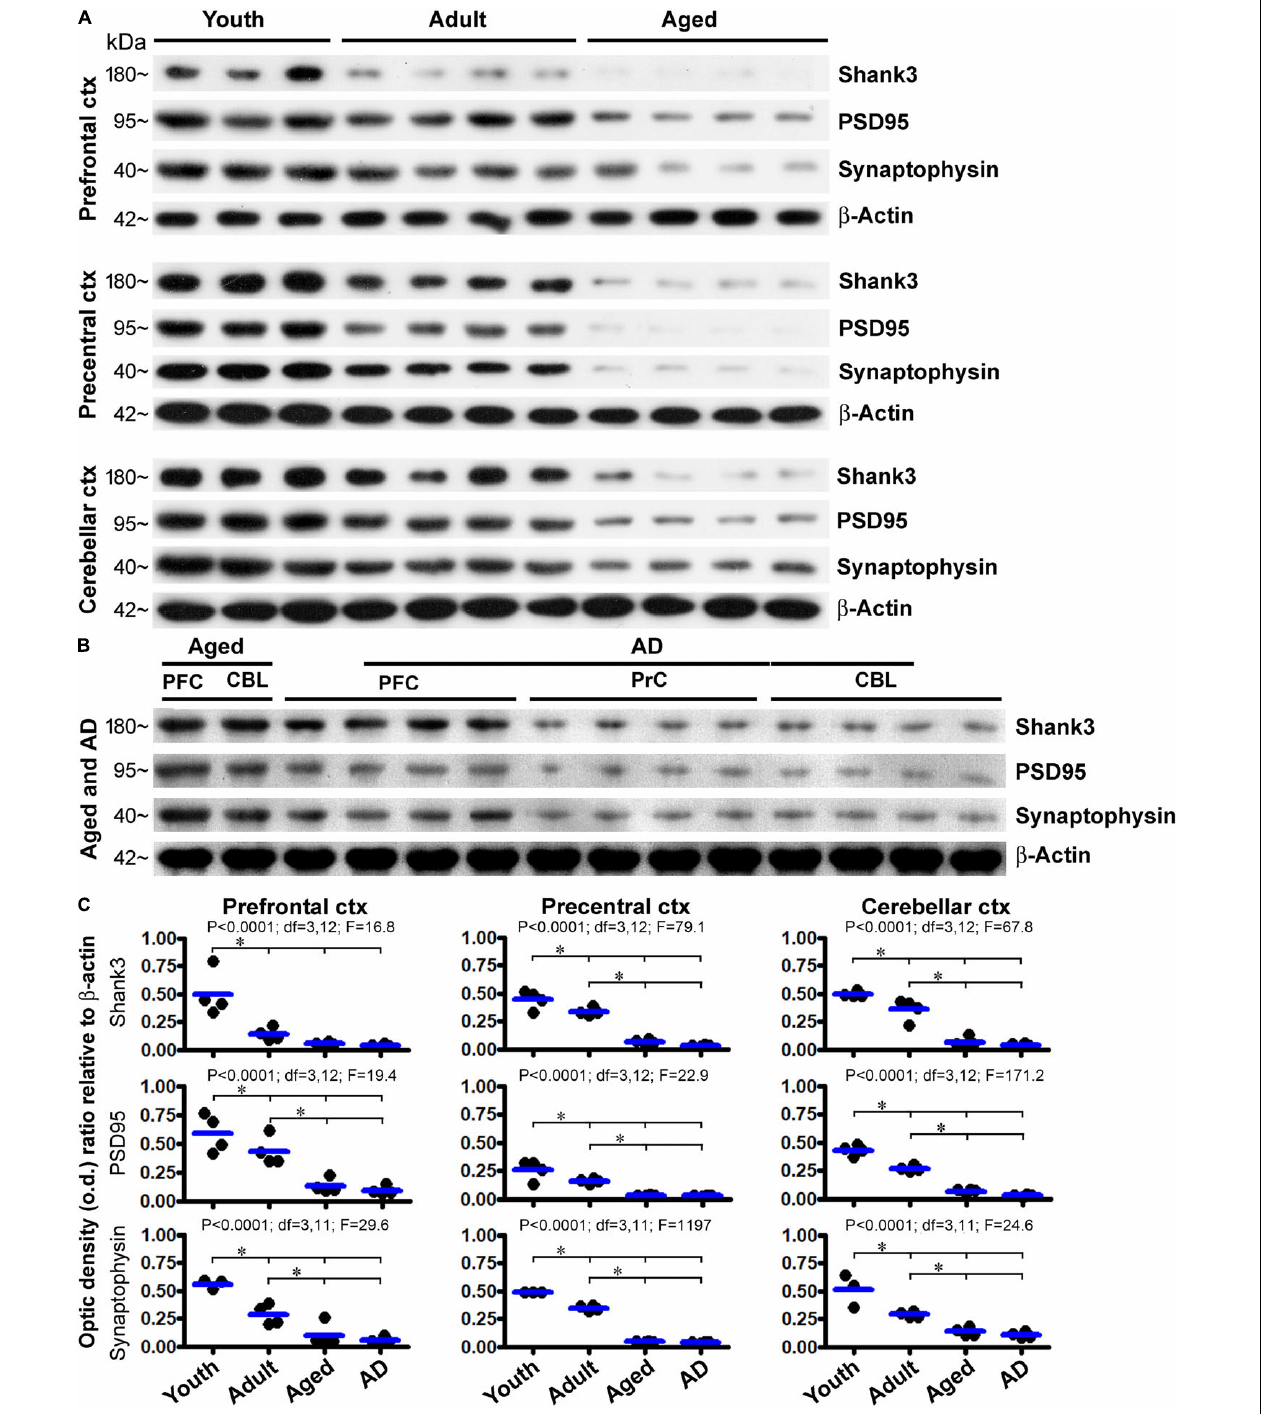
FIGURE 14 | Western blot profiling of age-related decline in the levels of Shank3, PSD95, and synaptophysin in the human prefrontal and precentral cerebral neocortex and the cerebellar cortex. Panel (A) shows images of the sets of immunoblotted protein bands, with the cases, groups, and protein markers as indicated. Protein loading was 10 µ g for all samples. Panel (B) shows immunoblotting images from another set of experiment to assess the protein levels in Alzheimer’s disease (AD) cases. Samples (lanes 1 and 2) from an aged case were included as a reference. In addition, a longer exposure time (than that for capturing the image shown in A ) was used to capture the image, given the low signal of the blotted protein already seen in the aged group (A) . Panel (C) plots the densitometric data and results of statistical analyses. P , df, and F values noted in each panel are based on one-way ANOVA, with * indicating significant difference of the means of individual pairing groups according to Bonferroni’s multiple comparison post hoc